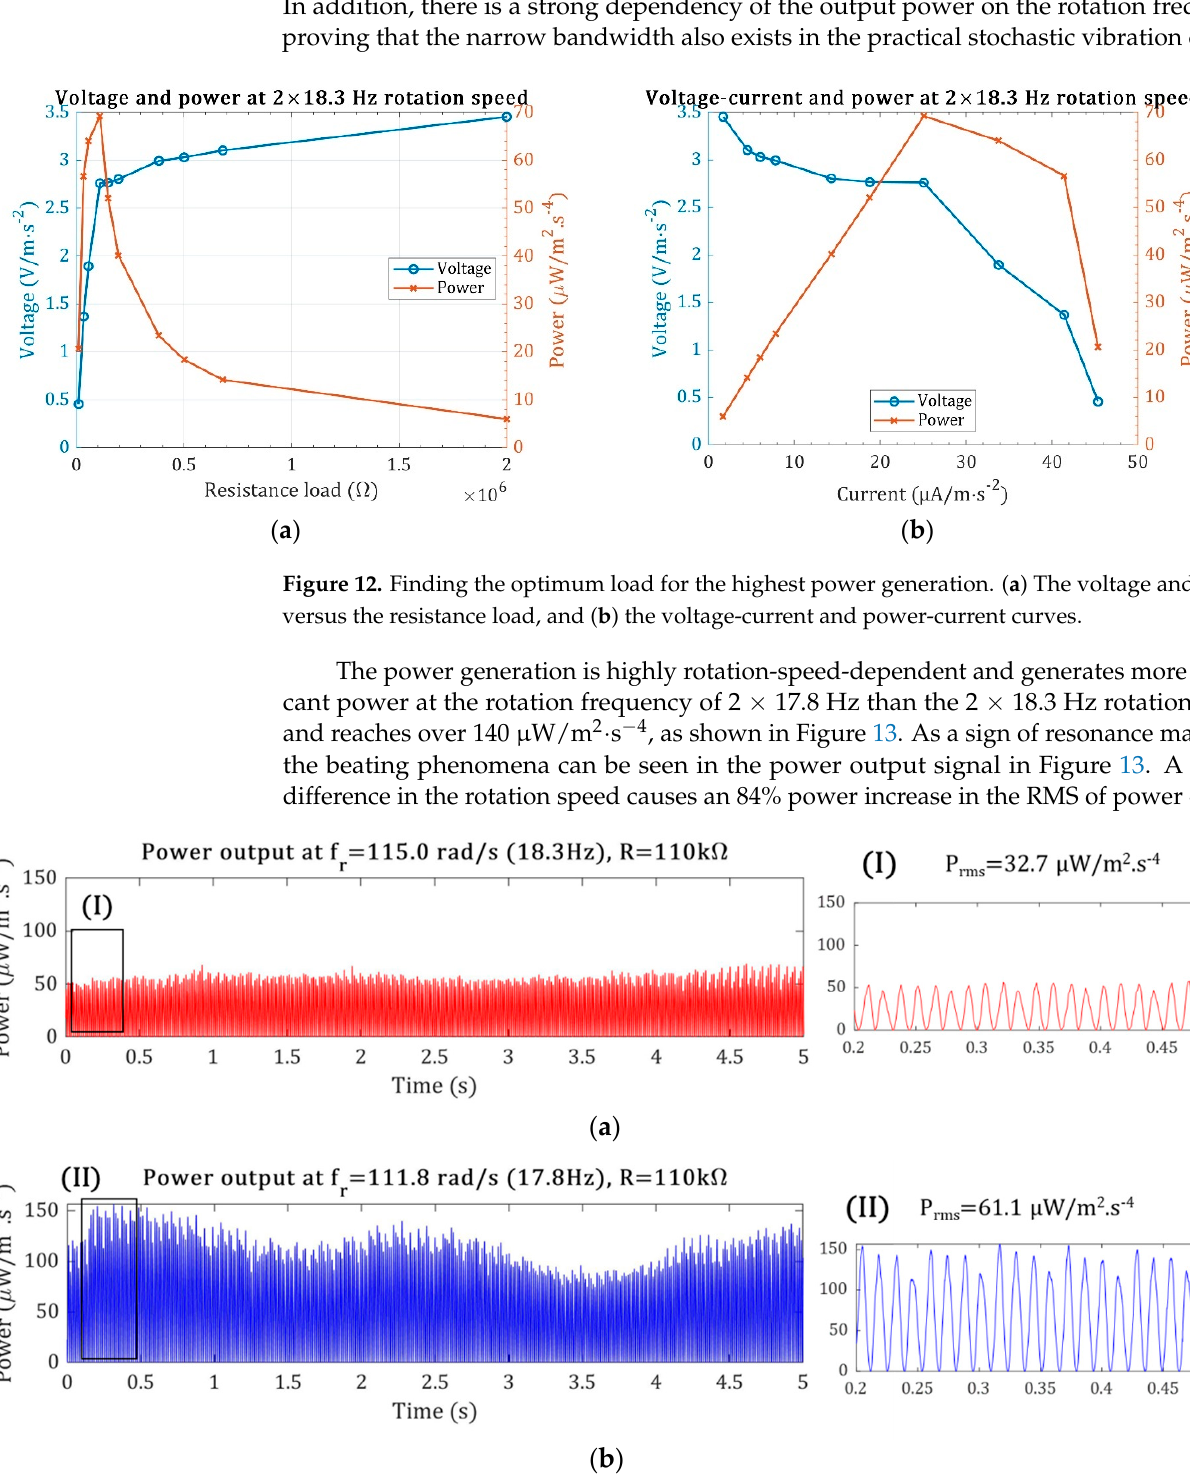
Figure 12. Finding the optimum load for the highest power generation. ( a ) The voltage and power versus the resistance load, and ( b ) the voltage-current and power-current curves.